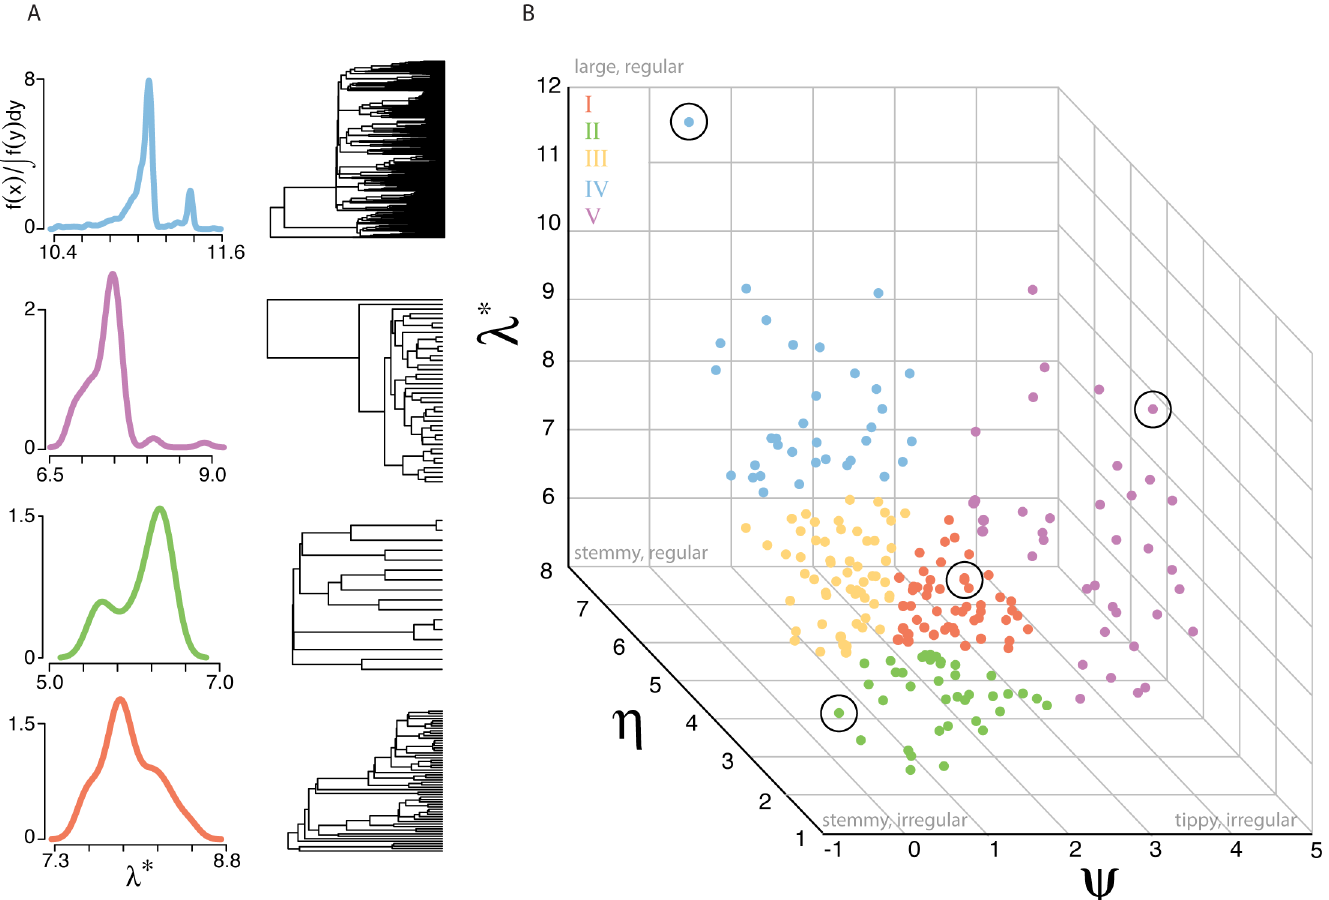
Fig 2. Vertebrate phylogenetic space. (A) Spectral density profiles and trees representative of different regions of phylogenetic space are shown: (top to bottom) Acanthizidae, Muridae, Pittidae, and Leporidae. (B) The distribution of trees in phylogenetic space defined by spectral density profile summary statistics: skewness ( ψ ), ln-transformed principal eigenvalue ( λ * ), and peak height ( η ). Points in phylogenetic space corresponding to trees in (A) are circled. Points in (B) are colored according to Fig 1. Summary statistics are listed in S1 Data.